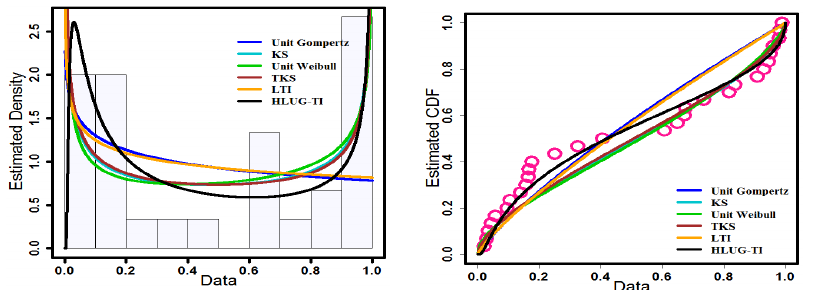
Figure 12. Estimated densities and empirical ( left ) and estimated CDF ( right ) for the data set I.